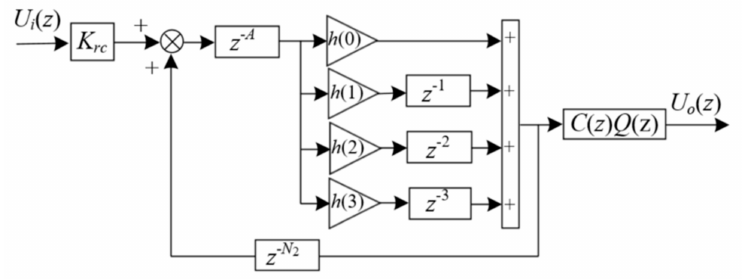
Figure 12. Structure of proposed repetitive controller in this paper.